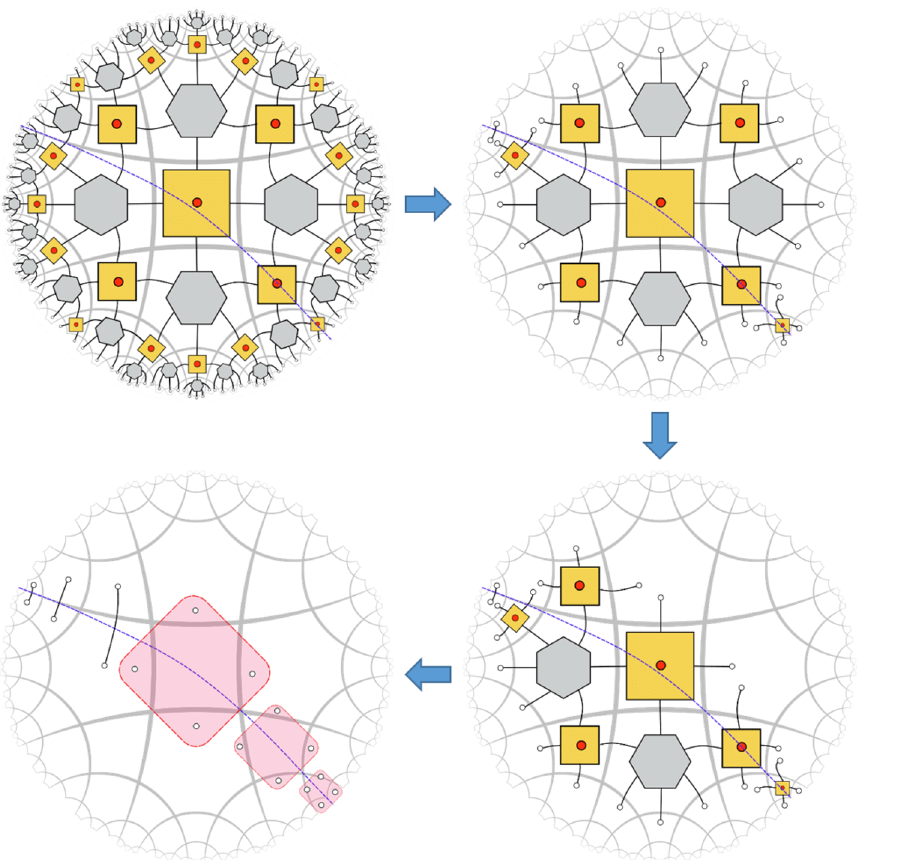
Figure 28. A bipartition is marked by the blue dashed line. The boundary degrees of freedom above and below the line are divided into two complementary sets. The entanglement can be distilled to Bell states (edges) and GHZ like states (hyperedges).